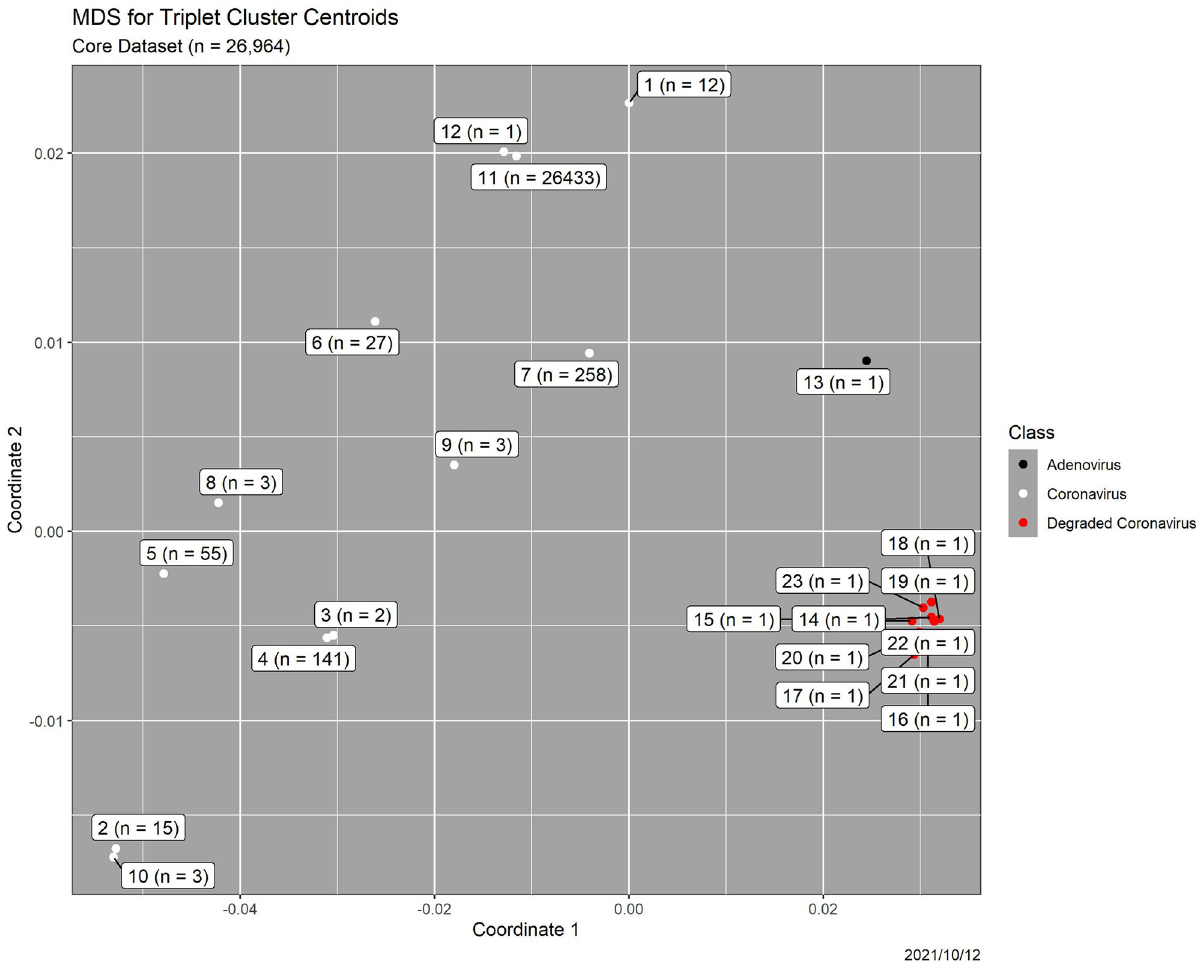
Fig 6. Results for triplet distribution clustering. Two-dimensional MDS plot of the 23 triplet distribution cluster centroids for a 26,964-element coronavirus database containing 11 deliberately added outliers. Labels are cluster numbers and counts. Greater distance implies higher dissimilarity.